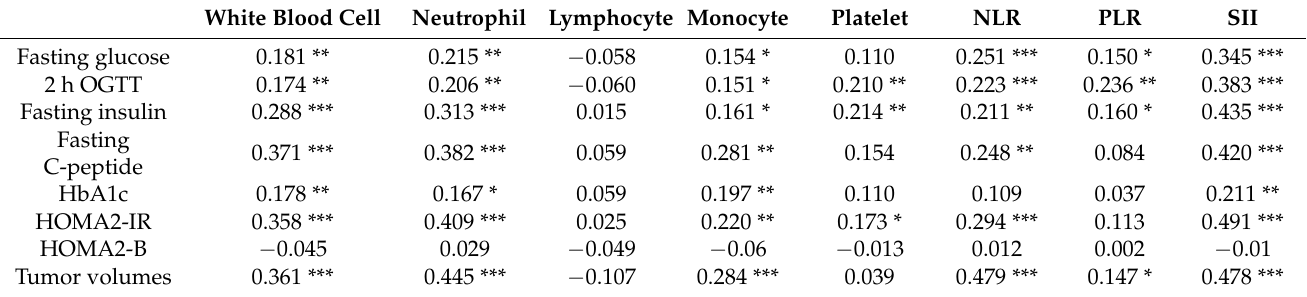
Table 2. Spearman correlation analysis between periphery blood indexes and glucose-related